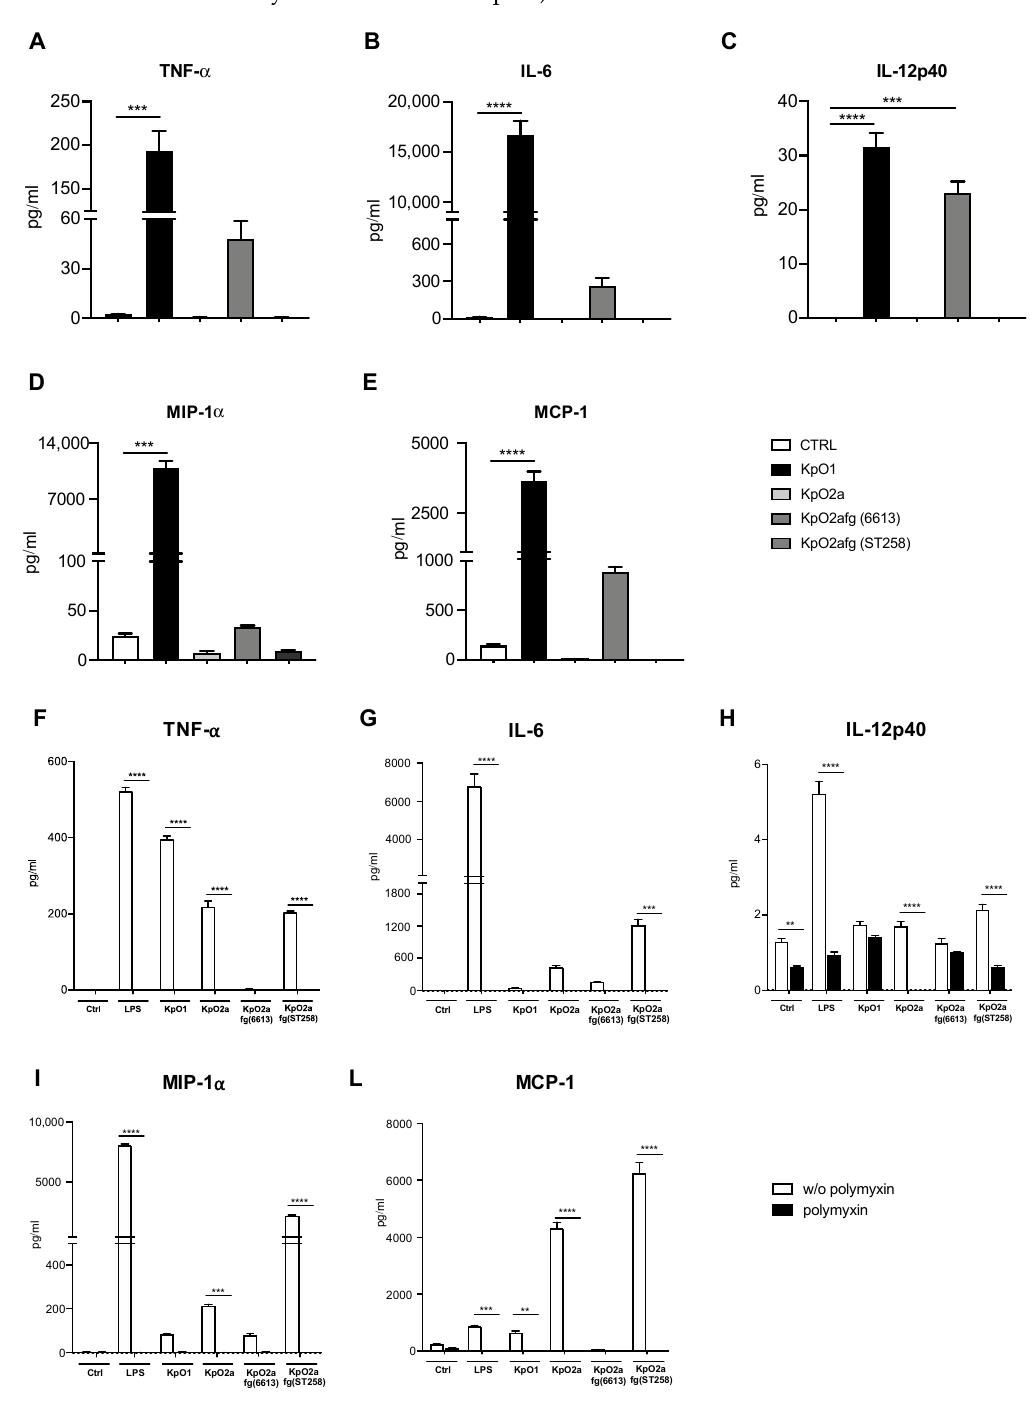
Figure 2. The stimulation of isolated monocytes for 48 h ( A – E ) and 6 h ( F – L ) with 1 µ g/mL of each of the different K. pneumoniae purified LPS (KpO1, KpO2, KpO2afg (6613) and KpO2afg (ST258)). LPS refers to E. coli 0111:B4 commercial LPS and it was also used at a concentration of 1 µ g/mL. Results are representative of four different donors. The results are expressed as the average ± SEM. Statistical analysis was performed using one-way ANOVA, ** p < 0.01, *** p < 0.001 and **** p <